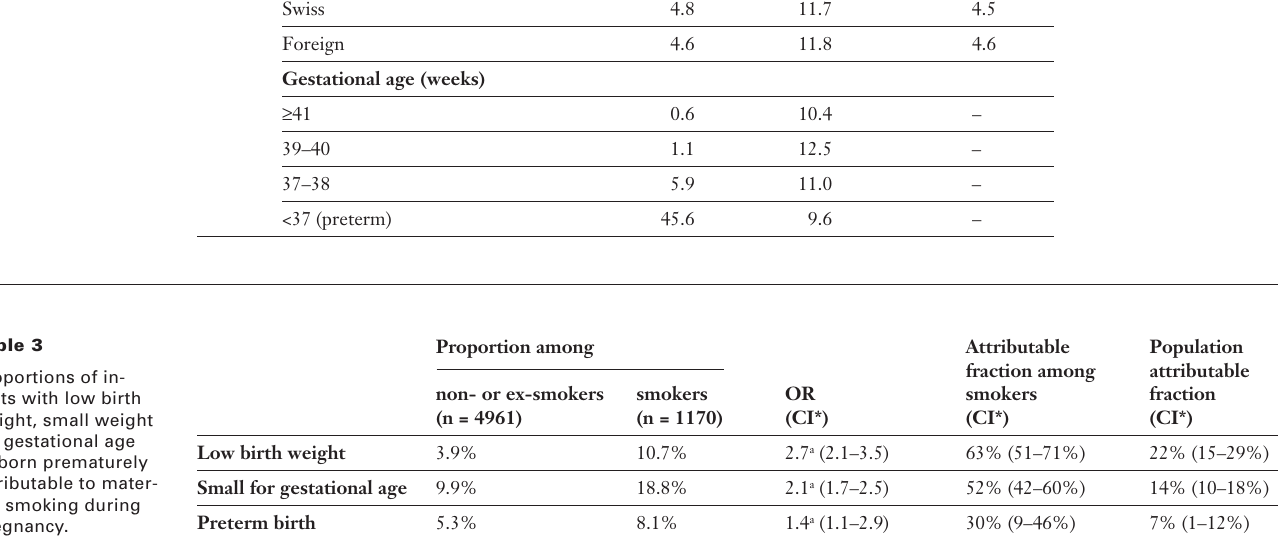
Association (odds ratio and 95% confi- dence interval*) be- tween categories of maternal smoking and low birth weight, small for gestational age or preterm